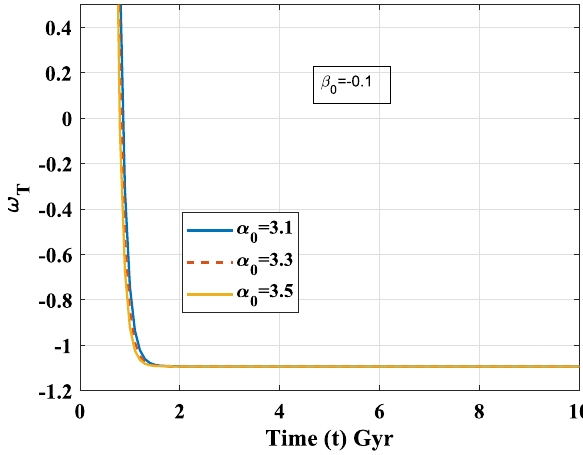
Fig. 5 Plot of ω T versus ω (cid:2) γ